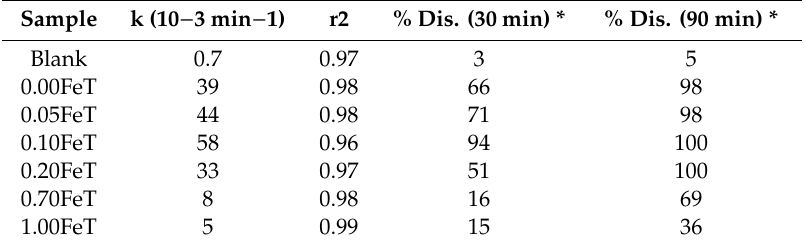
Table 3. Specific parameters of the photocatalytic e ffi ciency of Fe-doped TiO 2 nanoparticles.